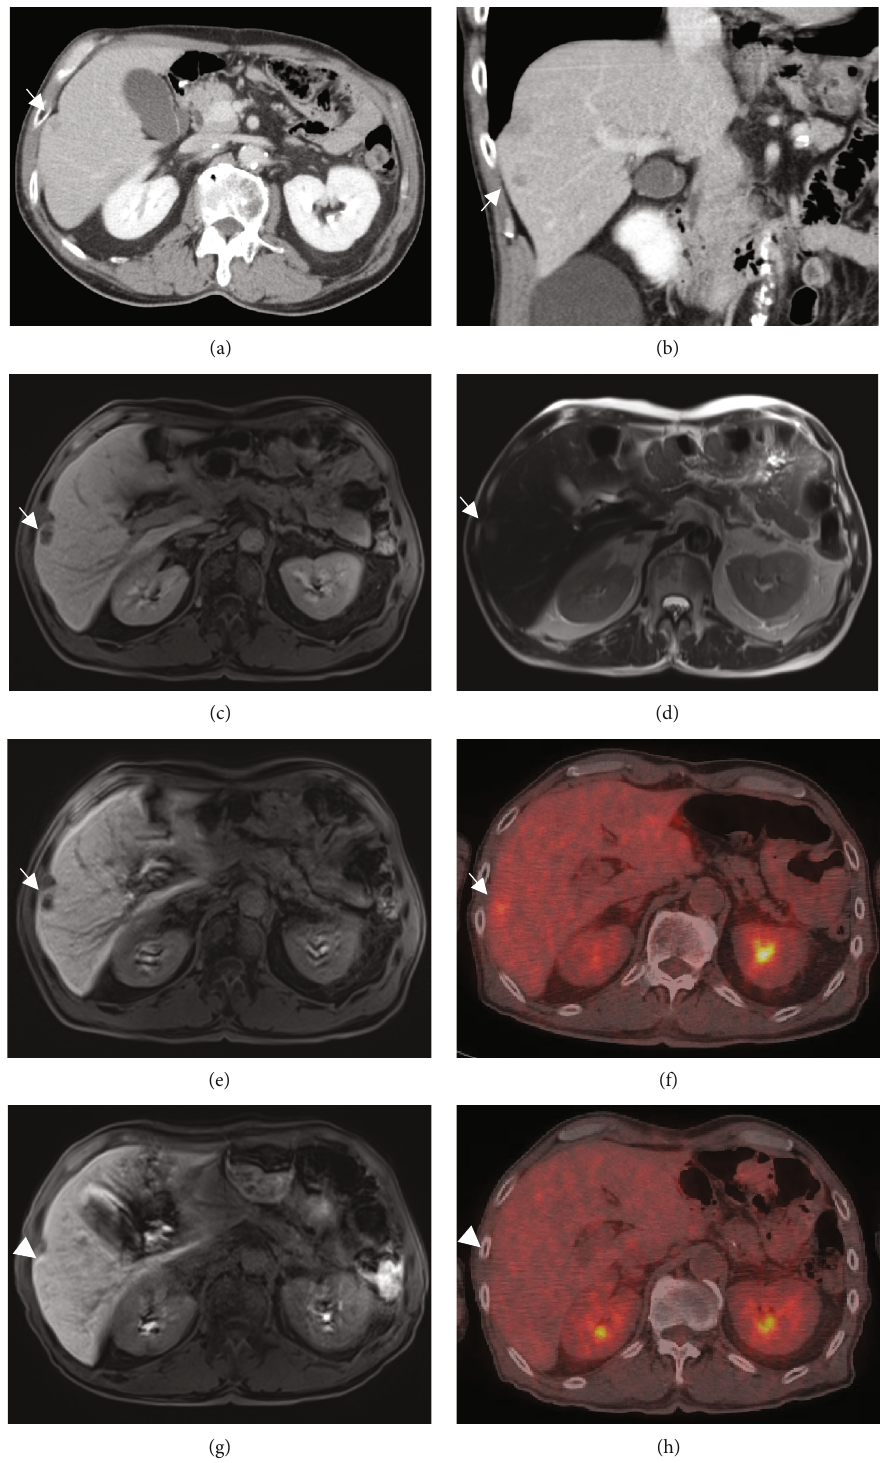
Figure 3: Radiological fi ndings following liver metastasis (segment 5/6) from AFP-producing gastric carcinoma contrast-enhanced computed tomography revealing a hypovascular nodule in segment 5/6 of the liver (a, b). T1- and T2-weighted MRI showing a low- signal nodule and slightly high signal, respectively; a 9mm defect is observed with EOB-MRI (c – e). 18 F-FDG PET/CT showing an abnormal accumulation of 18 F-FDG (maximum standardized uptake value of 4.8) at the same point (f). The tumor was undetectable on EOB-MRI after four courses of CapeOX therapy; no accumulation was detected on PET/CT (g, h). Abbreviations: CapeOX: capecitabine/ oxaliplatin; CT: computed tomography; EOB: gadolinium ethoxybenzyl-diethylenetriaminepentaacetic acid; MRI: magnetic resonance imaging; PET: positron emission tomography; 18 F-FDG: 2-deoxy-2-[ fl uorine-18] fl